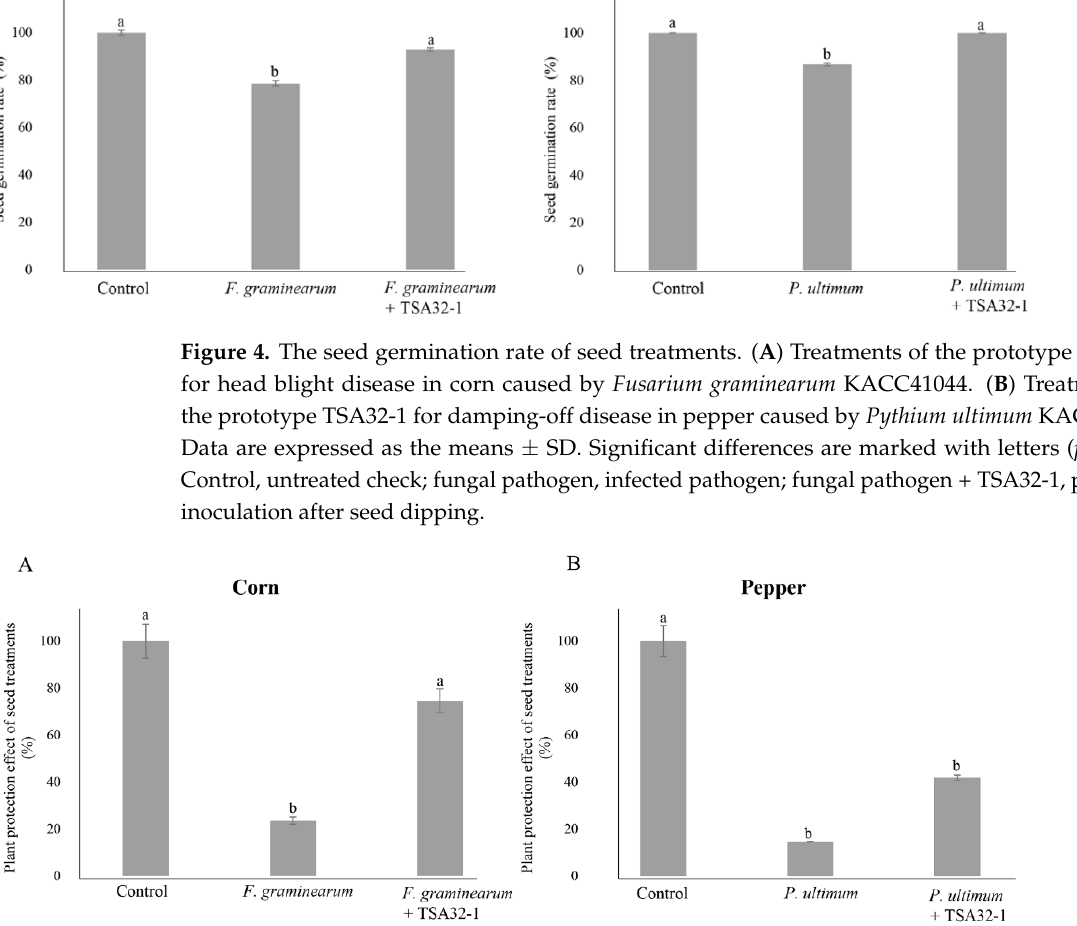
Figure 5. Plant protection effect of seed treatments. ( A ) Biocontrol agent effect of treatments of the prototype TSA32-1 for head blight disease in corn caused by Fusarium graminearum . ( B ) Biocontrol agent effect of treatments of the prototype TSA32-1 for damping-off disease in pepper caused by Pythium ultimum . Data are expressed as the means ± SD. Significant differences are marked with letters ( p < 0.05). Control, untreated check; fungal pathogen, infected pathogen; fungal pathogen + TSA32-1, pathogen inoculation after seed dipping.